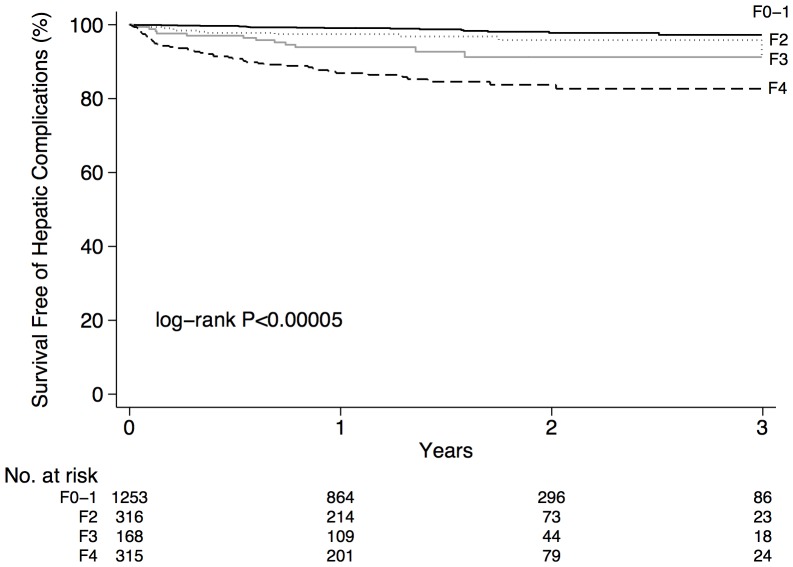
Unadjusted survival free of hepatic complications according to LSM by TE categorized as F0–1 (liver stiffness <7.1 kPa), F2 (7.1–9.4 kPa), F3 (9.5–12.4 kPa), and F4 (cirrhosis; ≥12.5 kPa).